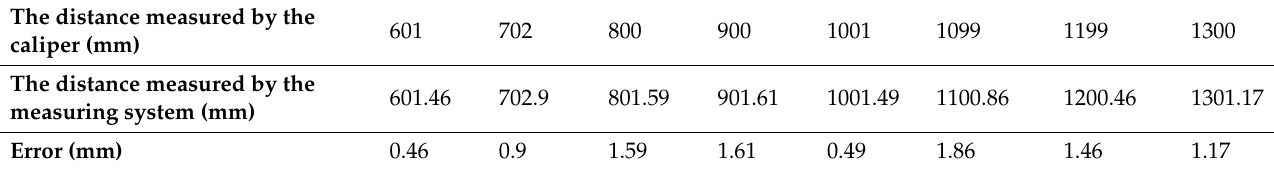
Table 5. Accuracy comparison of measurements between the visual measuring system and a caliper.